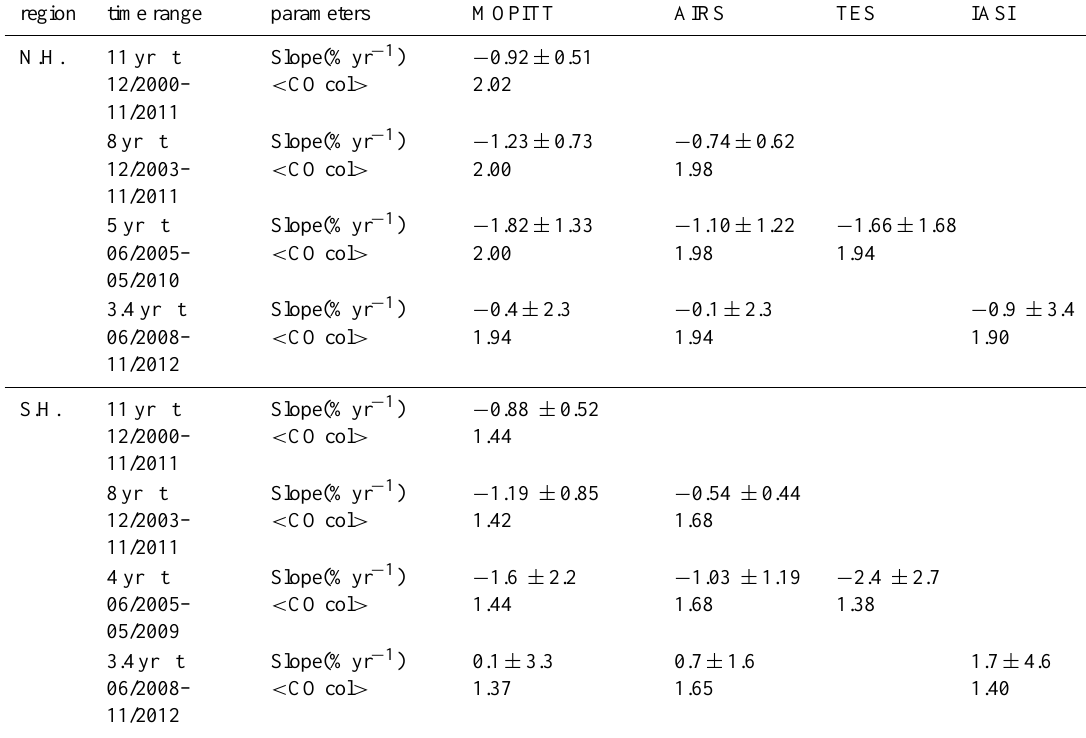
Table 4. Linear slope (%yr − 1 ) by instrument for available data records. Errors are 1 σ ; average CO columns for each time period are in 10 18 moleculescm − 2 .